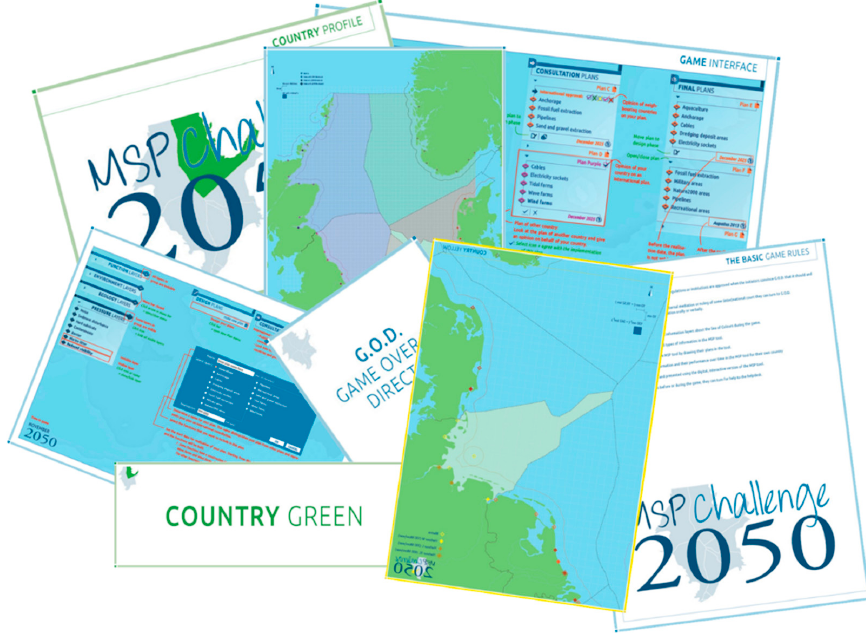
Figure 1. Game materials (adapted from [46]).